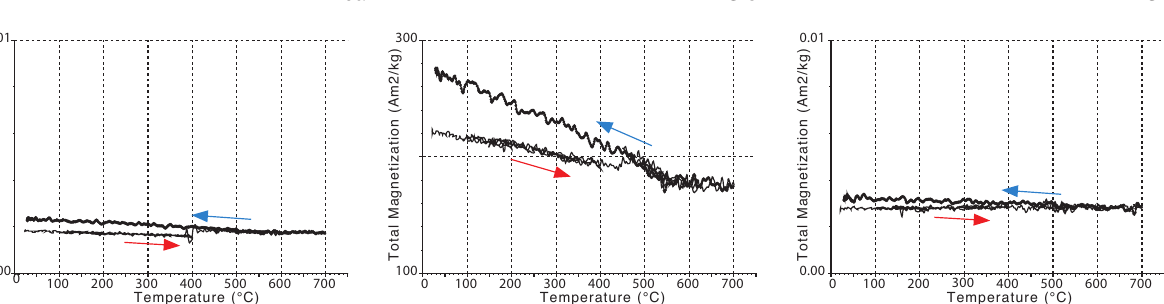
Figure 3. Thermomagnetic curves measured on a Curie balance (Mullender et al., 1993) for representative samples. Arrows indicate heating (red) and cooling